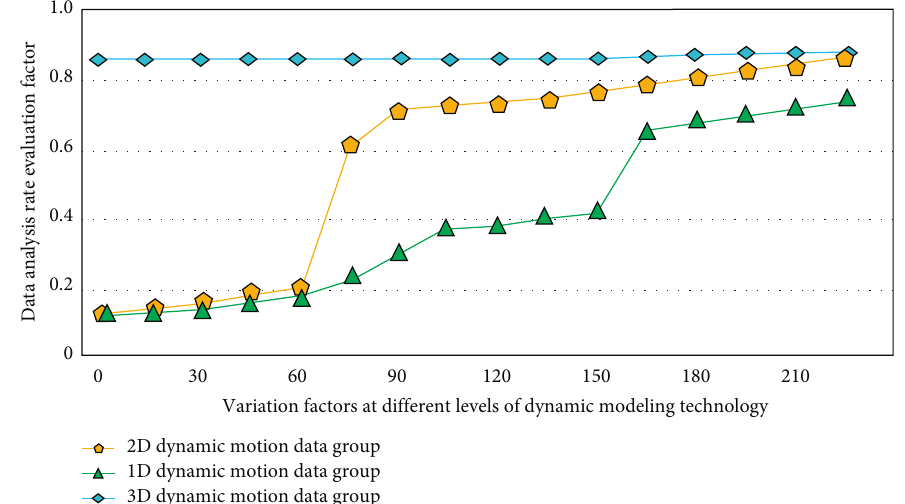
Figure 6: Simulation results of the relationship between the hierarchical variation factor and the analysis rate evaluation